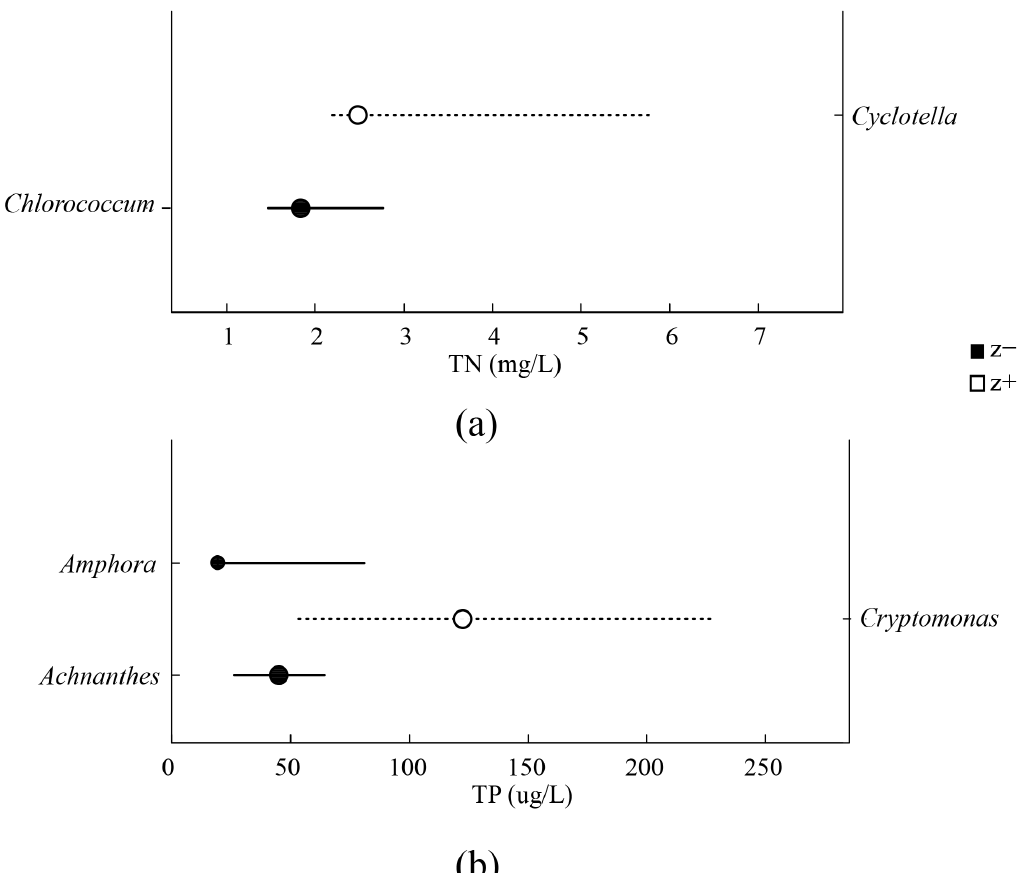
Figure 6. TITAN results showing significant indicator taxa. Circles showed taxa change points which were sized according to magnitudes of response. ( a ) Indicating species and thresholds of TN; ( b ) Indicating species and thresholds of